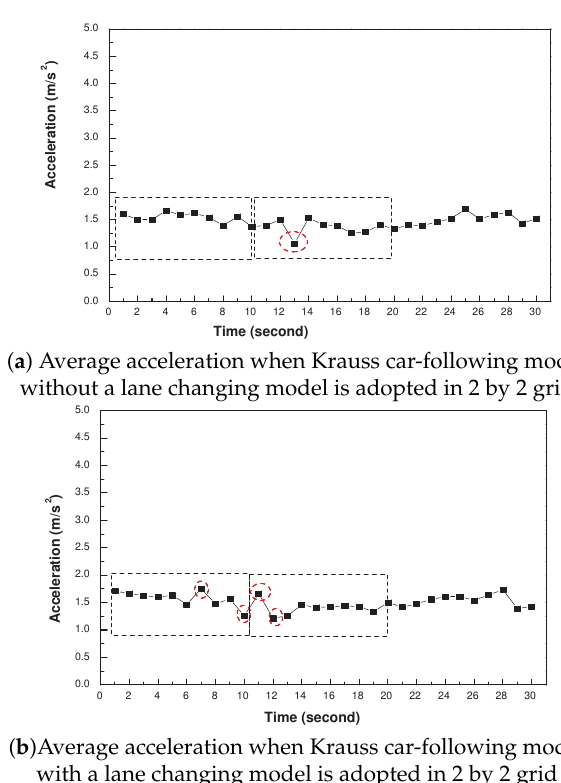
Figure 3. Average acceleration according to time in 2 by 2 grid obtained by SUMO: ( a ) Krauss model without lane changing model and ( b ) Krauss model with lane changing